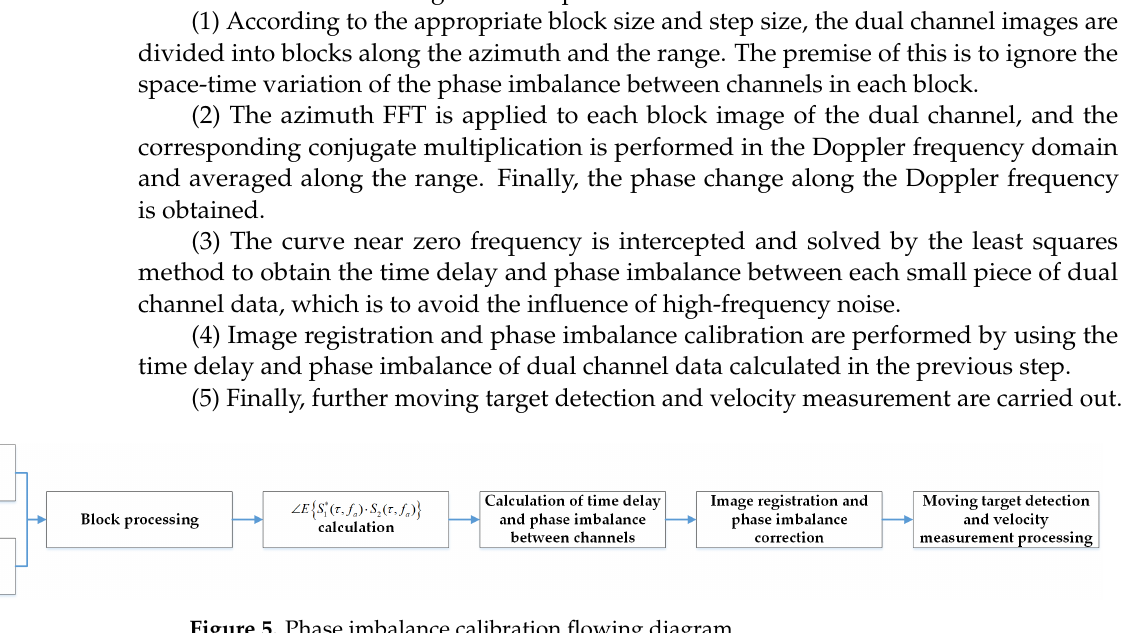
Figure 5. Phase imbalance calibration flowing diagram.